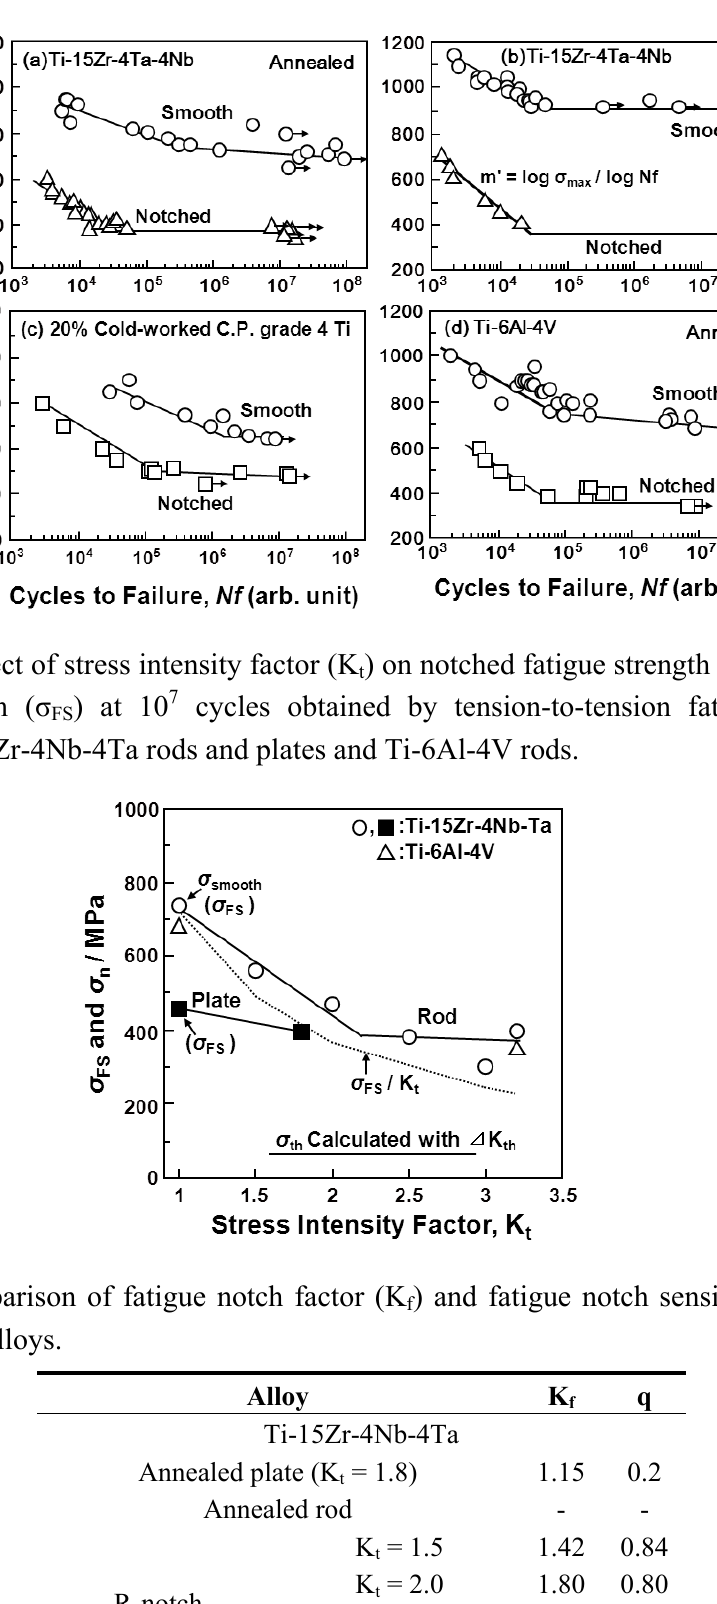
Figure 13. Effect of V-notch on S-N curves obtained by tension-to-tension fatigue test (sine wave, 10 Hz) for Ti alloys.